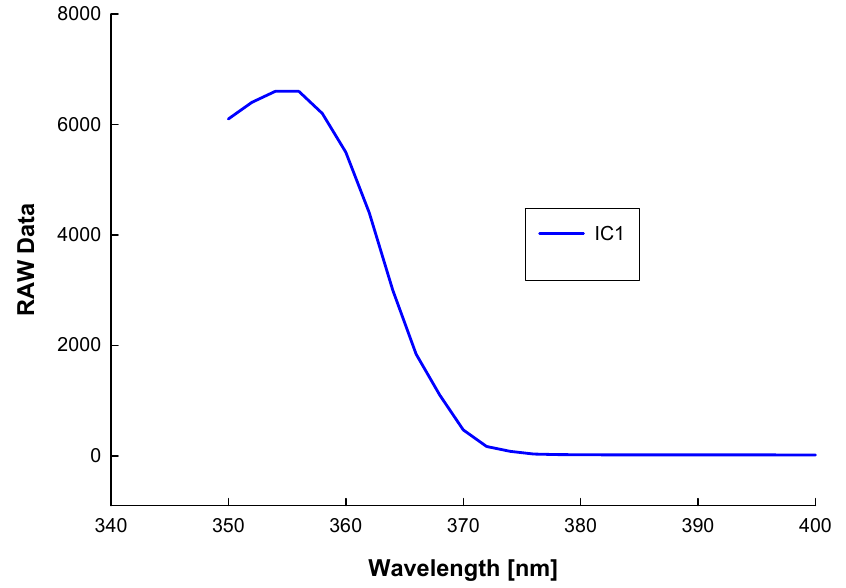
Figure 12. Measurements with the IC1 sensor under monochromator light source exposure.